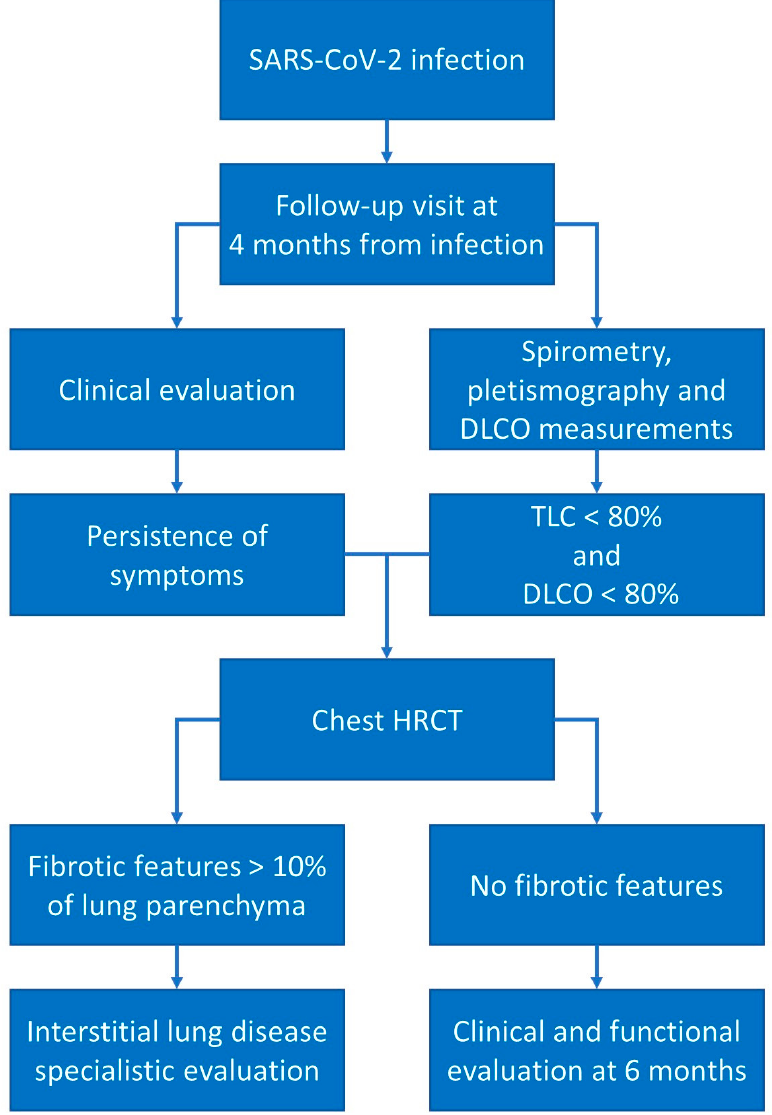
Figure 3. Post-COVID-19 follow-up schemes. In the presence of clinical and respiratory functional alterations, we suggest a follow-up high-resolution CT scan to investigate the presence of fibrotic